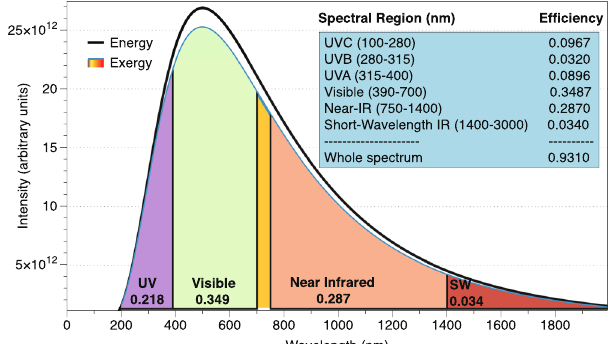
Figure 3. Energy and Exergy of two blackbodies at temperatures T = 5800 K and T 0 = 300 K, along with the second law efficiency or exergy efficiency of different spectral